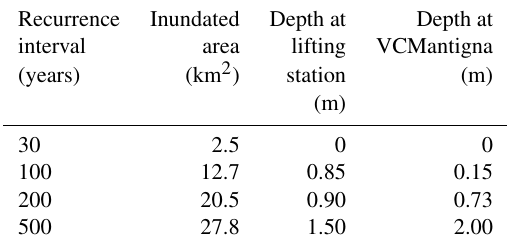
Table 2. Summary of exposed